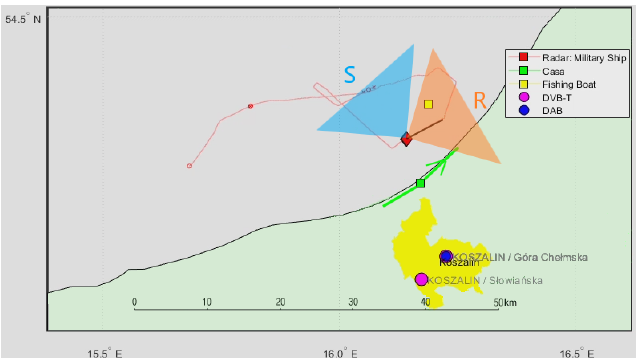
Figure 16. Situation map with a cooperative CASA C-295 aircraft and a distant fishing boat.